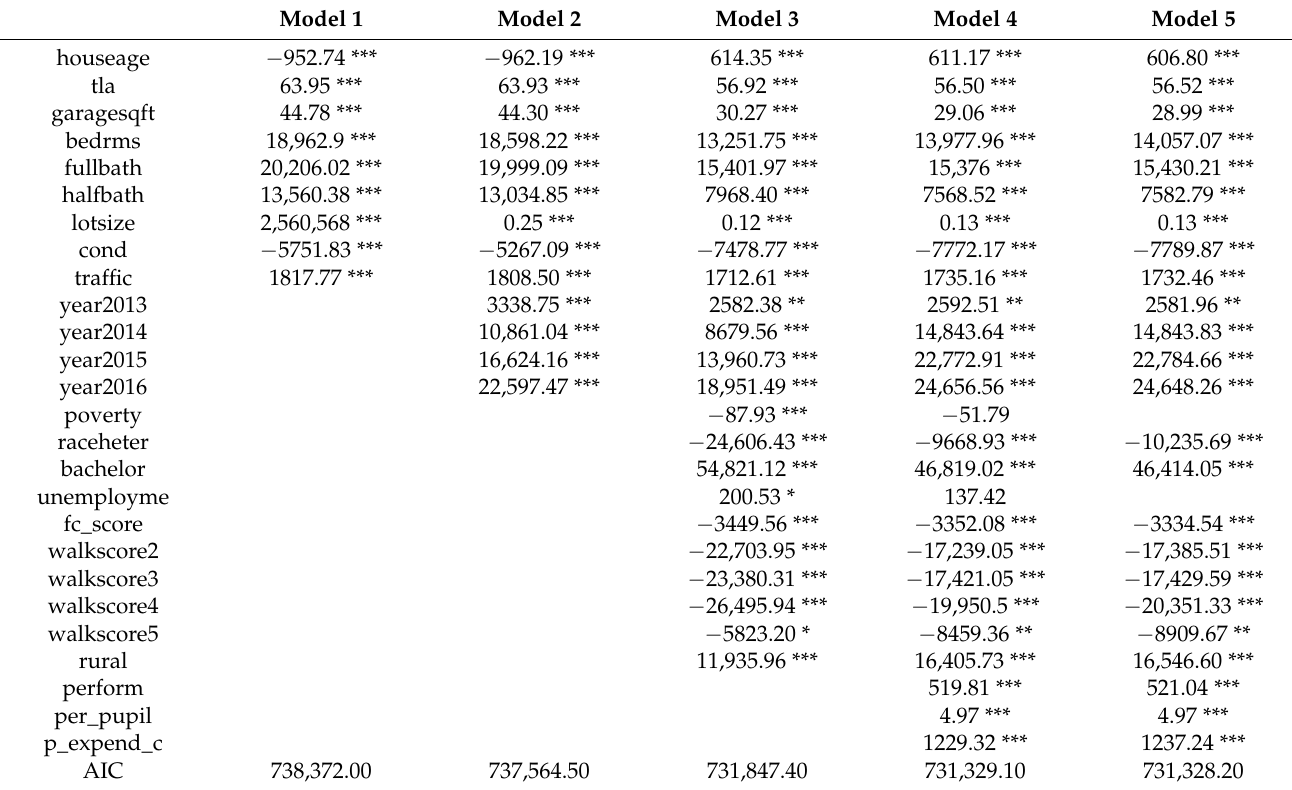
Table 6. Results of hierarchical linear